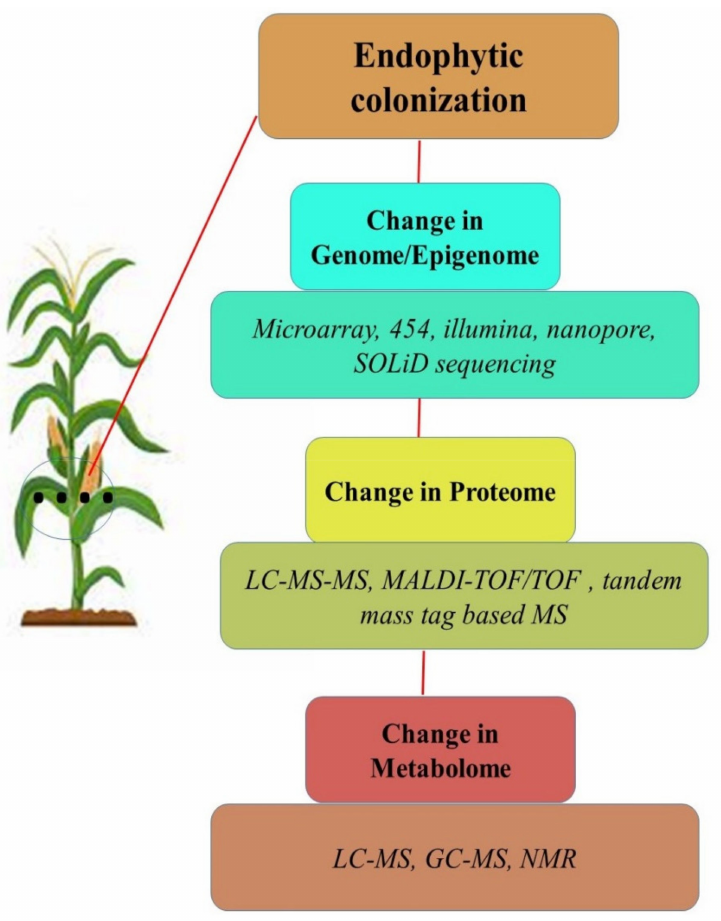
Figure 2. Overview of the ‘ome’ of plant-endophyte interactions under abiotic